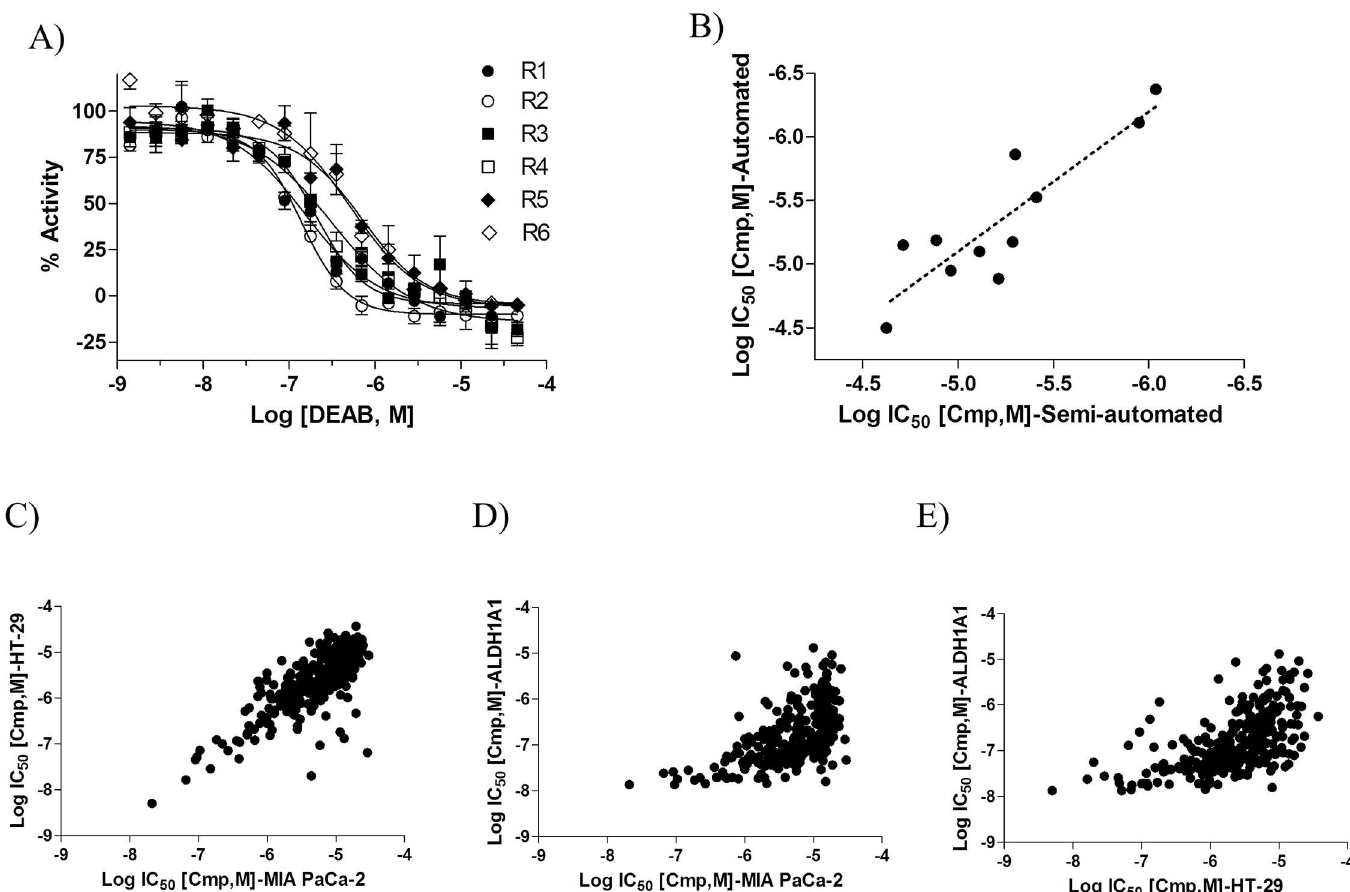
Fig 4. Assayautomation. (A) DEAB dose responsecurves of 1,000 cells/wellMIA PaCa-2 cells incubatedwith 500 nM of BAAA substrate for 30 min. R1 to R4 represent four different independent replicates of the fully automatedassay. R5 and R6 represent two different independent replicates of the semi- automatedassay. Data is represented as mean +/- SD, n = 2. ( B ) Semi- and automatedcellularBAA intensity measurements provide similar IC 50 values for active compounds.Correlation plot of Log IC 50 values of 11 active compounds in the semi-automated (x-axis) and automated(y-axis) assays. Inactive compoundsare not included.( C ) Correlation plot of Log IC 50 values of 288 active compoundsin MIA-PaCa-2 (x-axis) and HT-29 (y-axis) cells. Inactive compoundsare not included.( D, E ) Correlation plot of Log IC 50 values for 288 active compoundsin enzymatic ALDH1A1 assay (y-axis) and ALDEFLUOR assay (x-axis) in MIA-PaCa-2 (D) and HT-29 (E) cells. Inactive compoundsare not included.